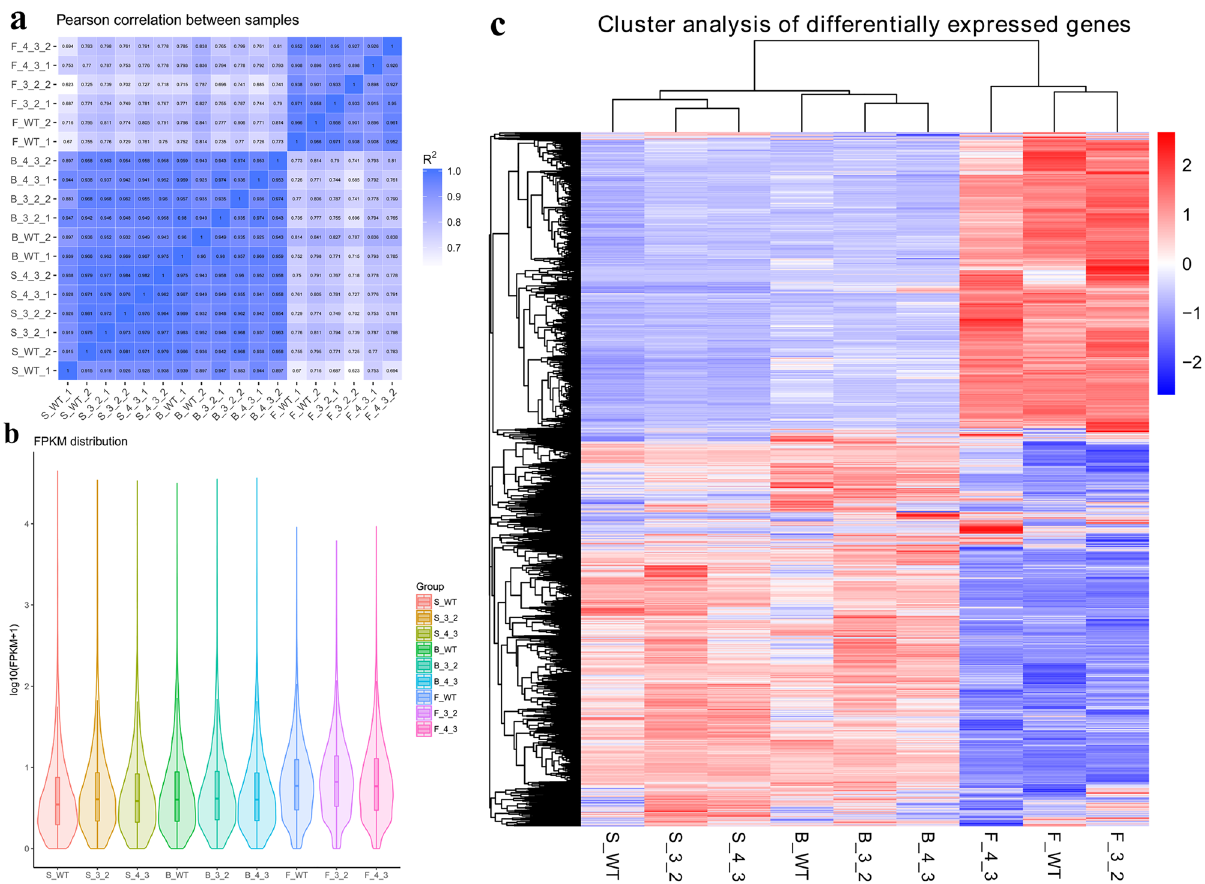
Figure 2. Primary analysis of transcriptome datas. ( a ) Heat map of Pearson correlation coefficient between samples; ( b ) Violin diagram of gene expression level in wild type and transgenic lines at different stages; ( c ) Heat map for cluster analysis of the differentially expressed transcripts. The color scale corresponds to the log 2 (FPKM) values of genes in various samples, red represented up-regulated expression and blue represented down-regulated